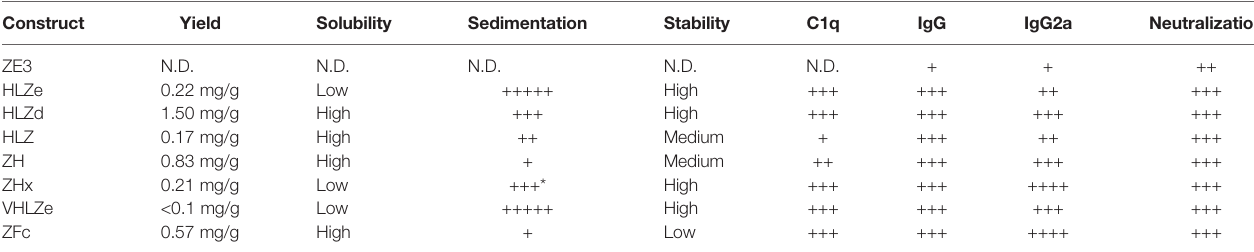
TABLE 1 | Summary of characteristics of IgG